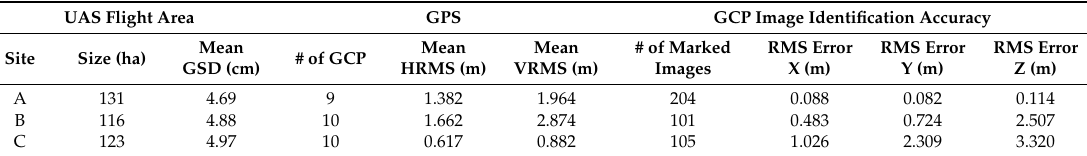
Table 3. Study area characteristics, horizontal and vertical RMS error (HRMS, VRMS) acquired from the DGPS measurements of GCP points used for georeferencing of the DAP point cloud and GCP image identification accuracies averaged per study